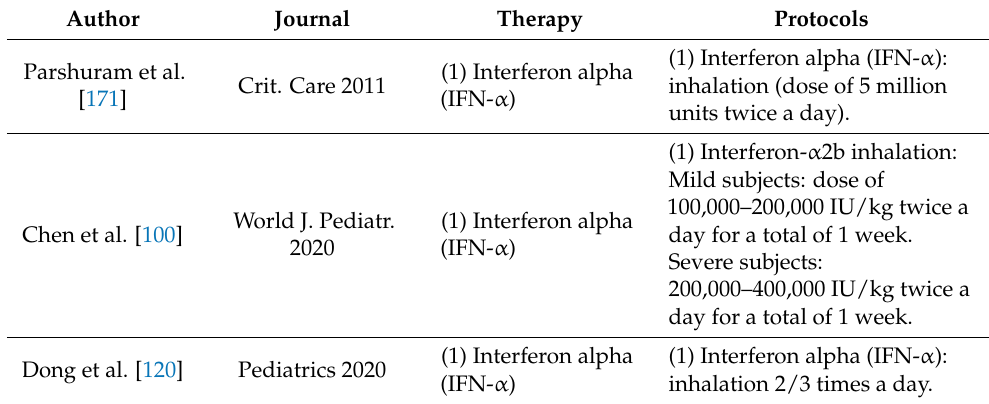
Table 4. Summary of adjuvant aerosol treatments for COVID-19.